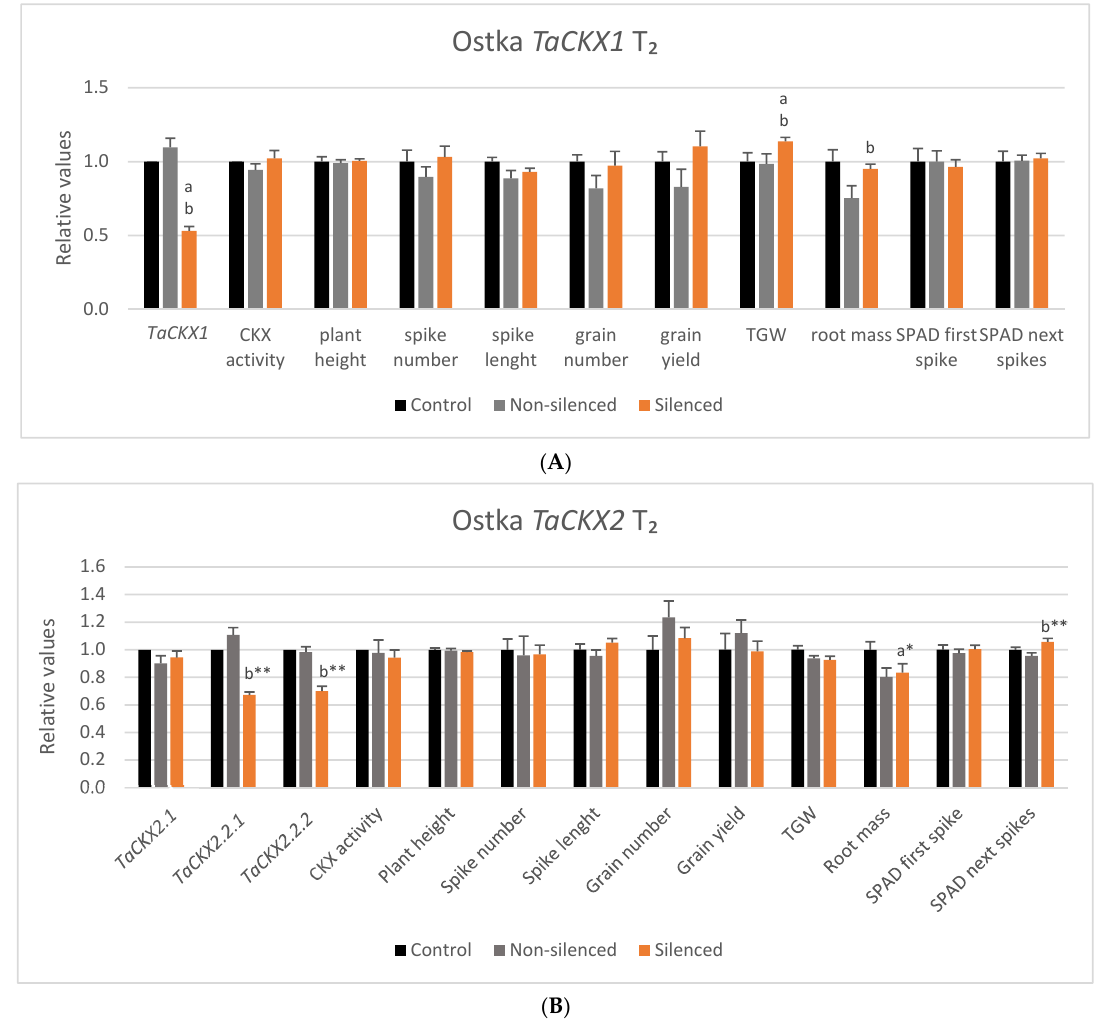
Figure 5. Relative values of TaCKX1 expression and yield-related traits in TaCKX1 ( A ) and relative values of TaCKX2.1 , 2.2.1 and 2.2.2 expression and yield-related traits in TaCKX2 ( B ) silenced (orange bars), nonsilenced (grey bars) and control (black bars) of T 2 lines. Error bars denote ± SE. Significant differences between control and silenced (a) and nonsilenced and silenced (b): * significant at p ≤ 0.05; ** significant at p ≤ 0.01.